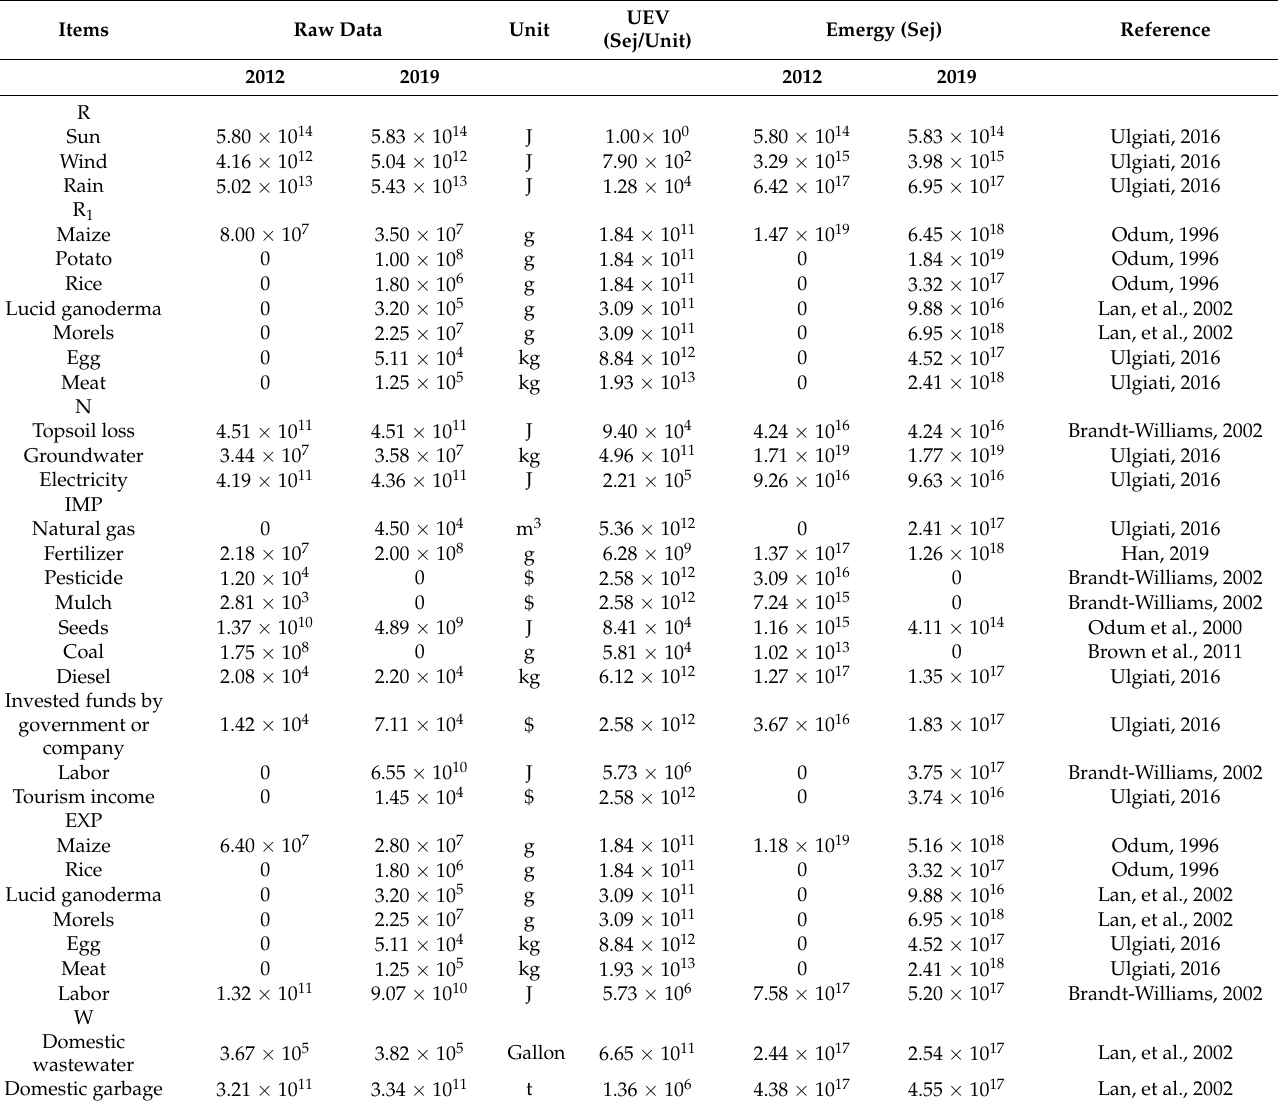
Table 2. Emergy accounting of Chehe Village in the year of 2012 and